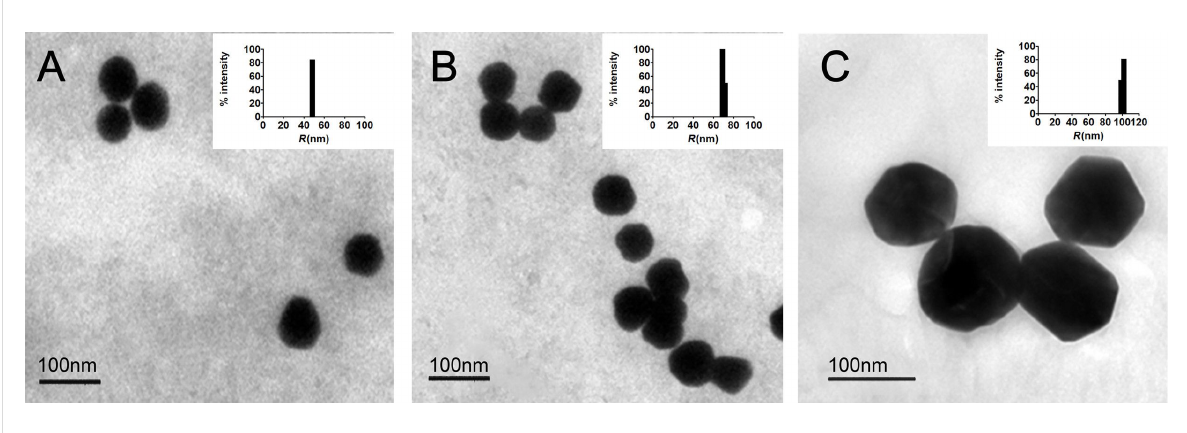
Figure 1: Unstained TEM images of Au-CPMV with the corresponding DLS size distribution histograms (inset). (A) 50 nm Au-CPMV particles; (B) 70 nm Au-CPMV particles; (C) 100 nm Au-CPMV.